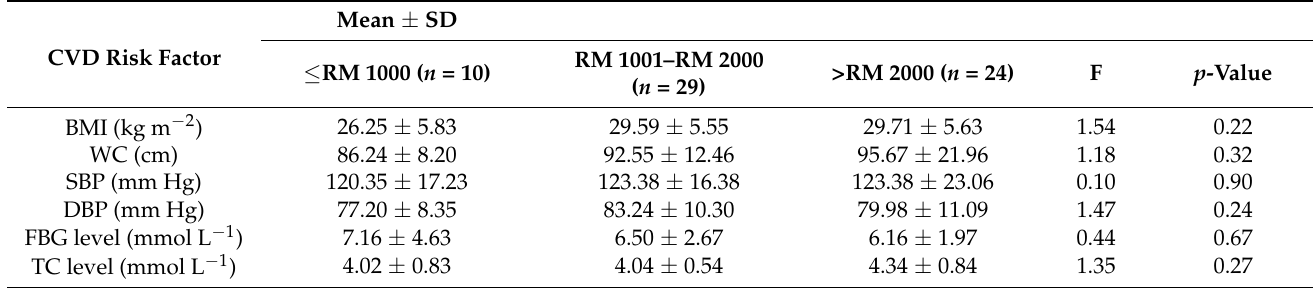
Table 4. Mean differences between CVD risk factors and household income.